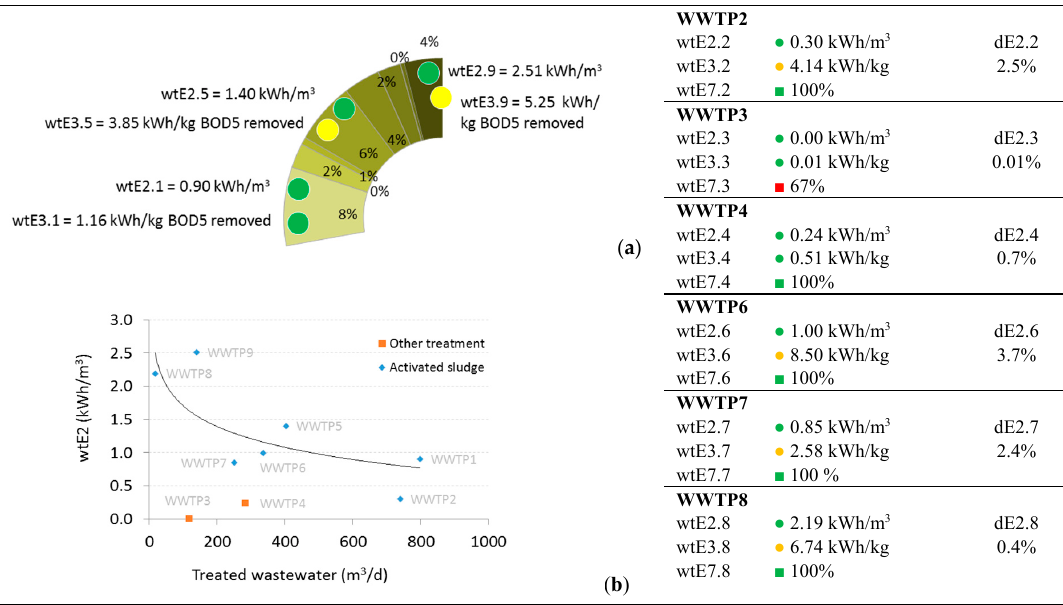
Figure 6. Energy consumption, energy efficiency and effectiveness in Utility K, for ( a ) wastewater treatment stage (level 3 of analysis) (the pie charts represent the energy consumption in each wastewater treatment plant in brownish-green; the circles represent the energy efficiency PIs and the squares the effectiveness PIs) and ( b ) energy consumption (wtE2, kWh/m 3 ) vs. treated wastewater (m 3 /day).